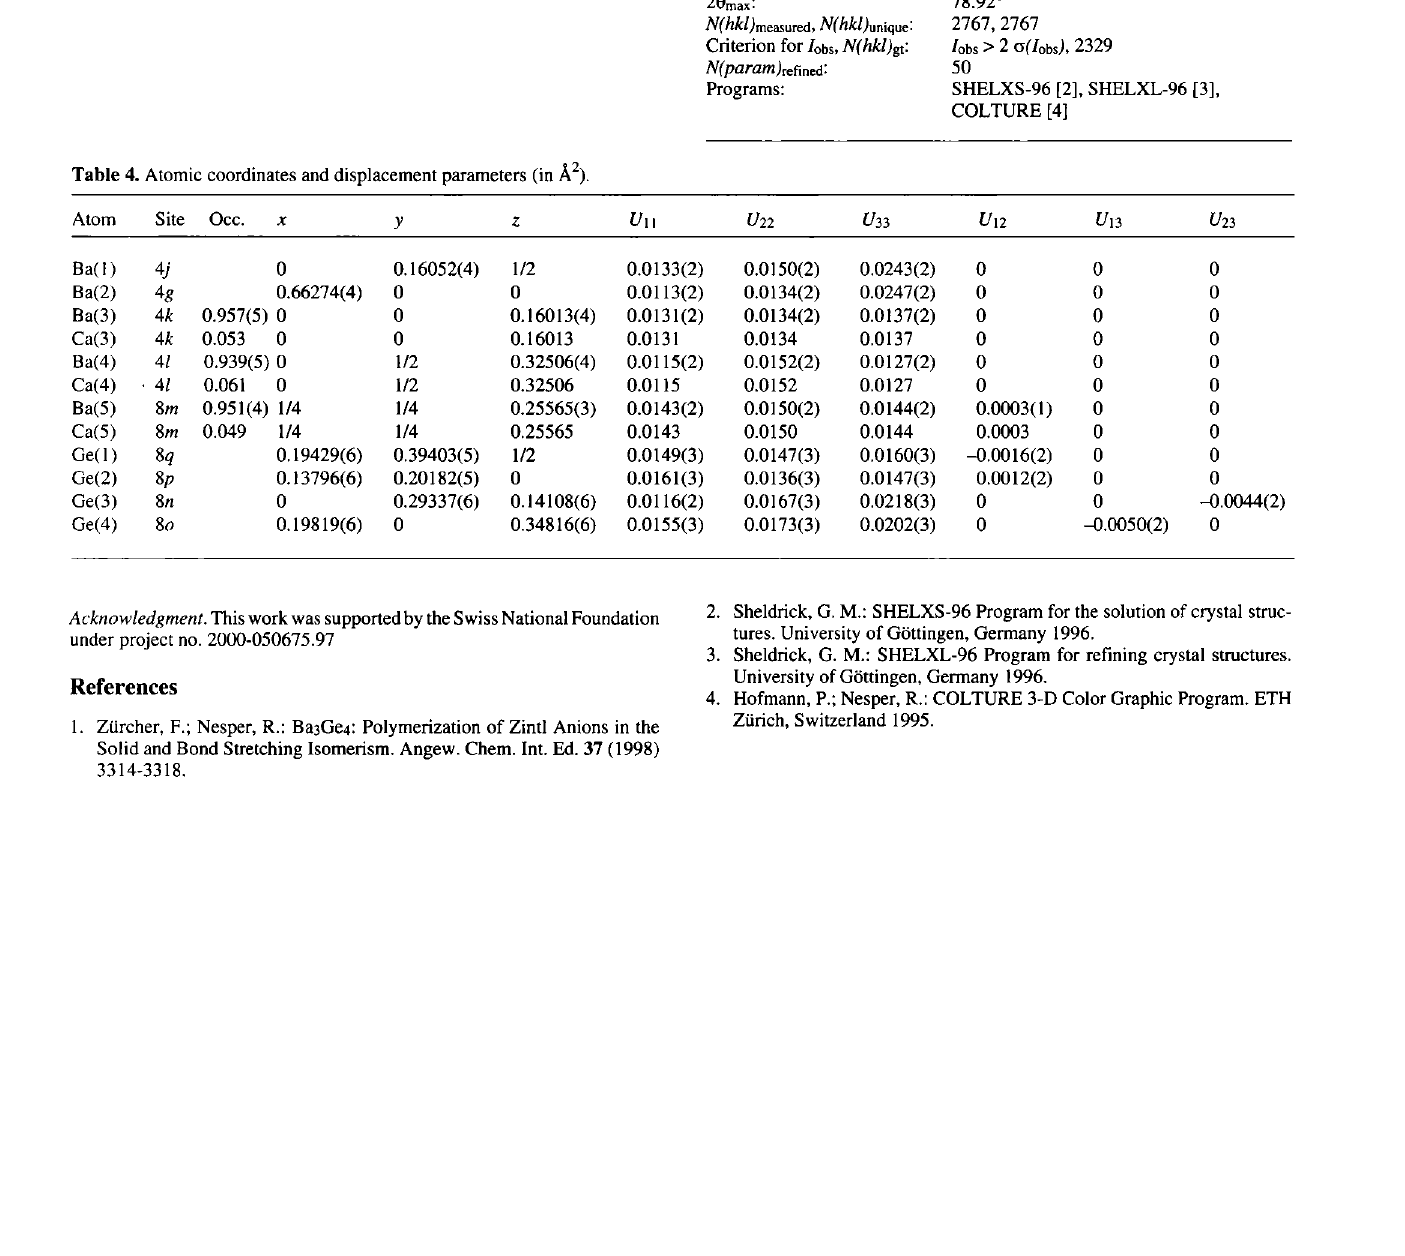
Table 4. Atomic coordinates and displacement parameters (in Ä 2